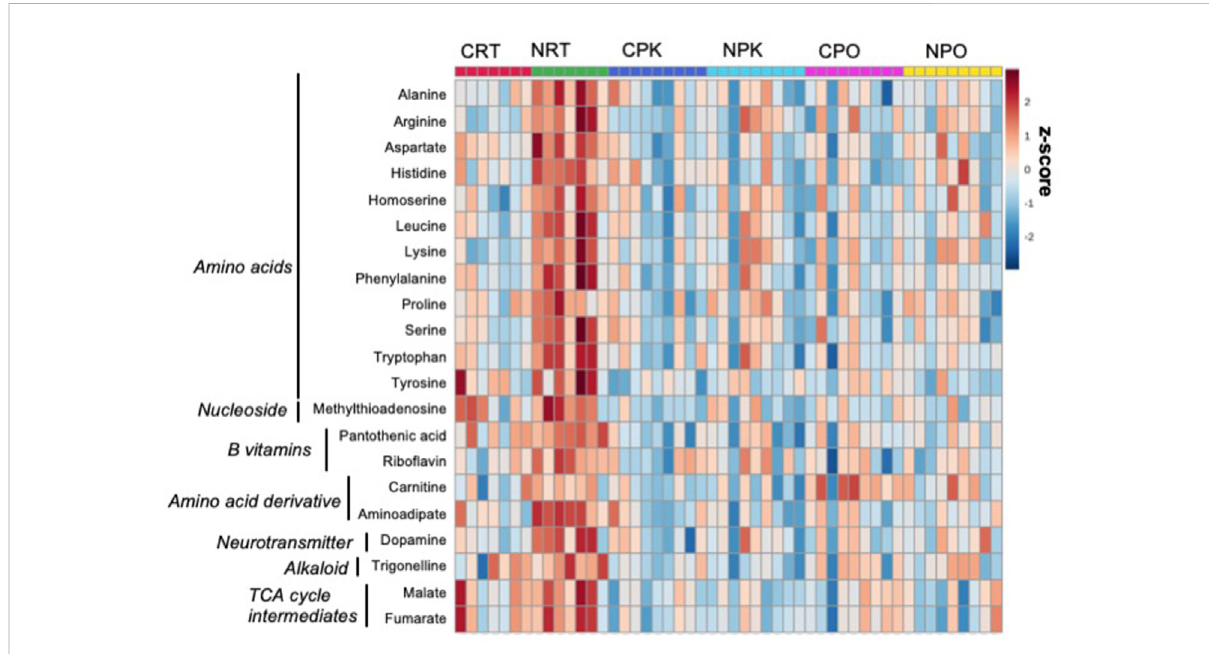
FIGURE 1 Nitrate treatment altered abundance of metabolites at rest, compared to control liver at rest. The metabolites were chosen based on top FDR- corrected p -values and physiological signi fi cance. Colors indicate z-score (standard deviation from the mean). The heat map was generated